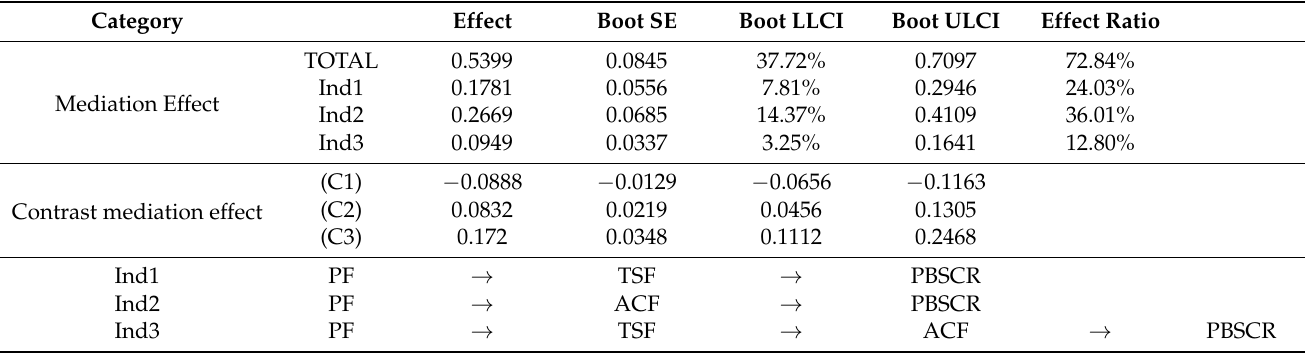
Table 7. Results of the intermediary effect